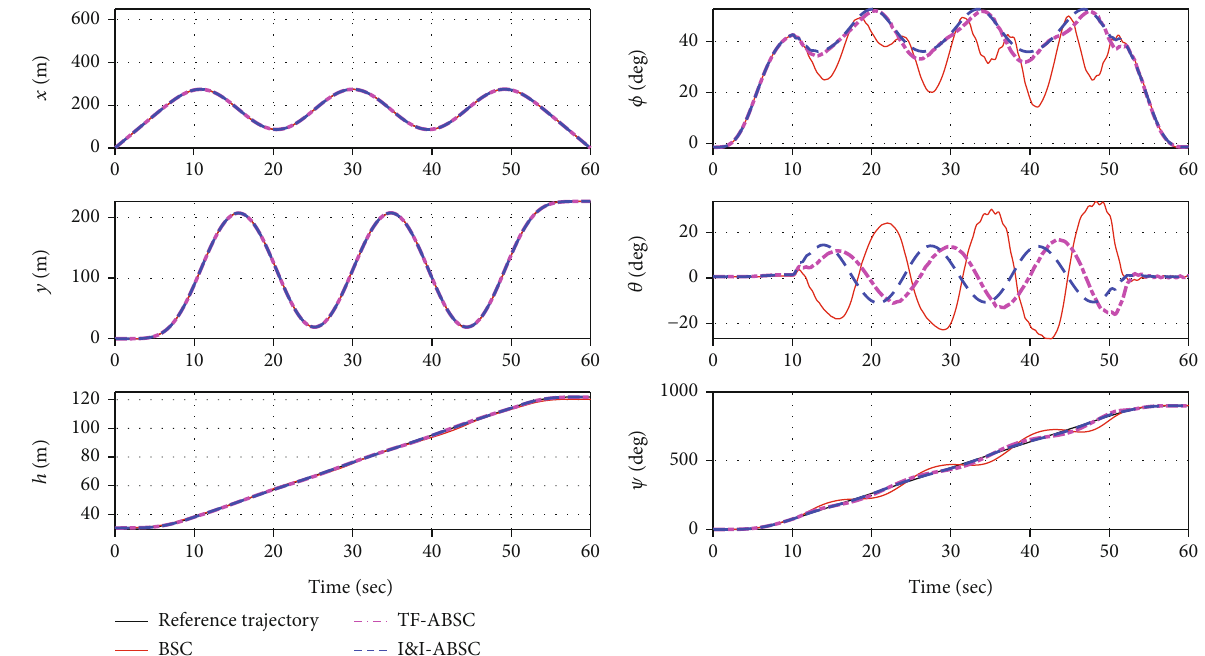
Figure 10: Case B: position tracking results of BSC, TF-ABSC, and